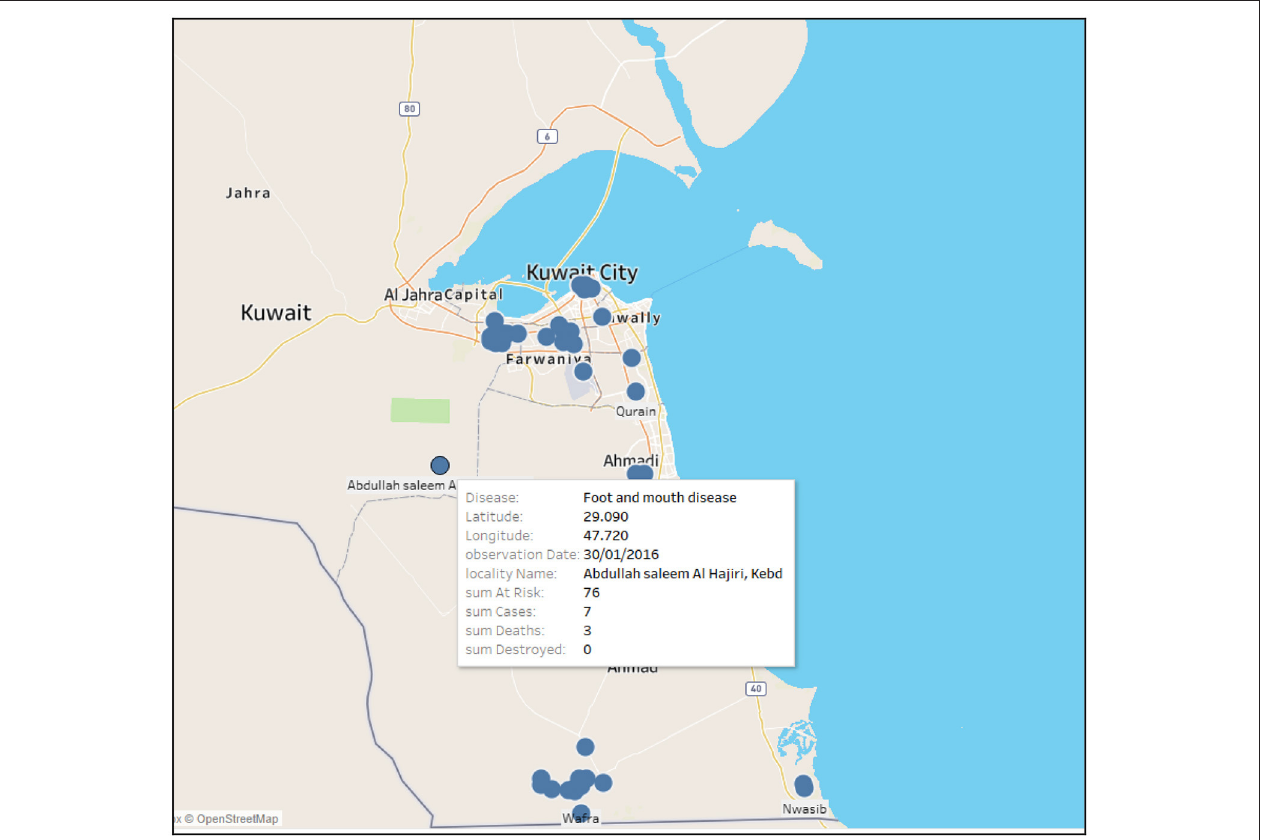
FIGURE 2 | Example of a web based analytic system map showing the coordinates of FMD outbreak at a specific farm on 30/01/2016 with all outbreak information [i.e., sum at risk (susceptible), confirmed cases, deaths, destroyed].